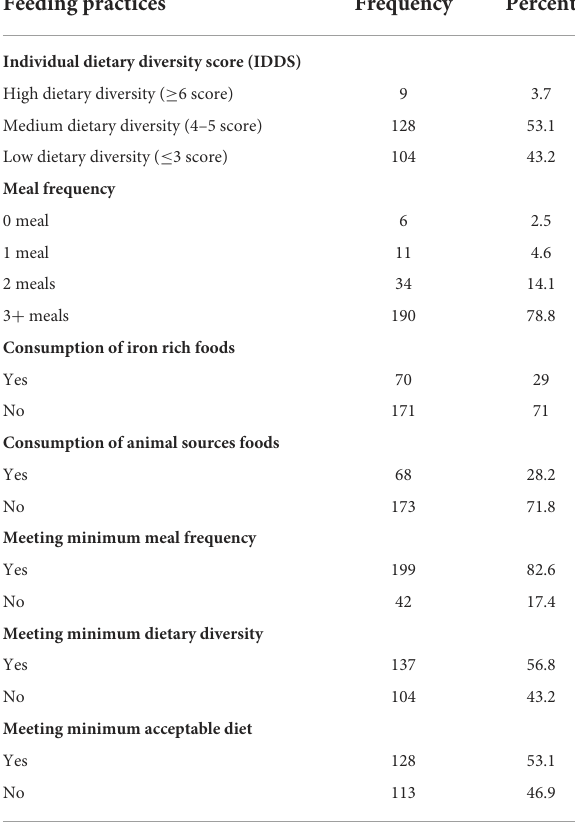
TABLE 3 Distribution of children (6–23 months) by the feeding practices ( n = 241). Feeding practices